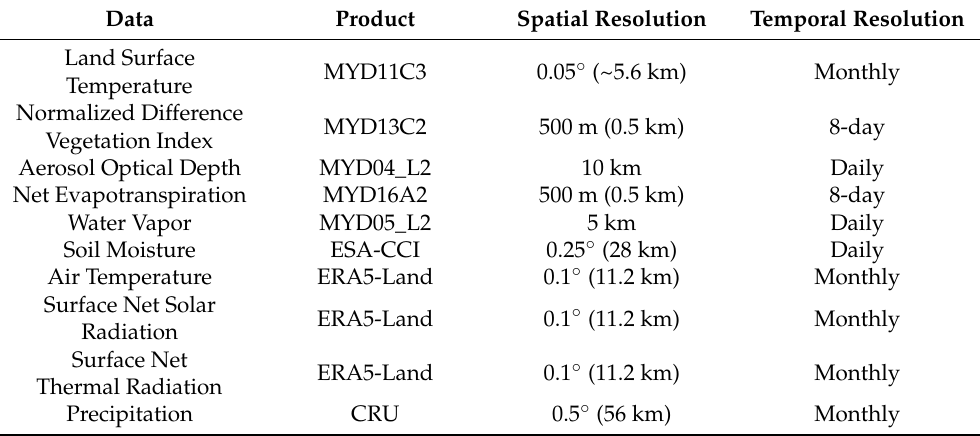
Table 1. Basic information about the satellite observation and reanalysis data used in this